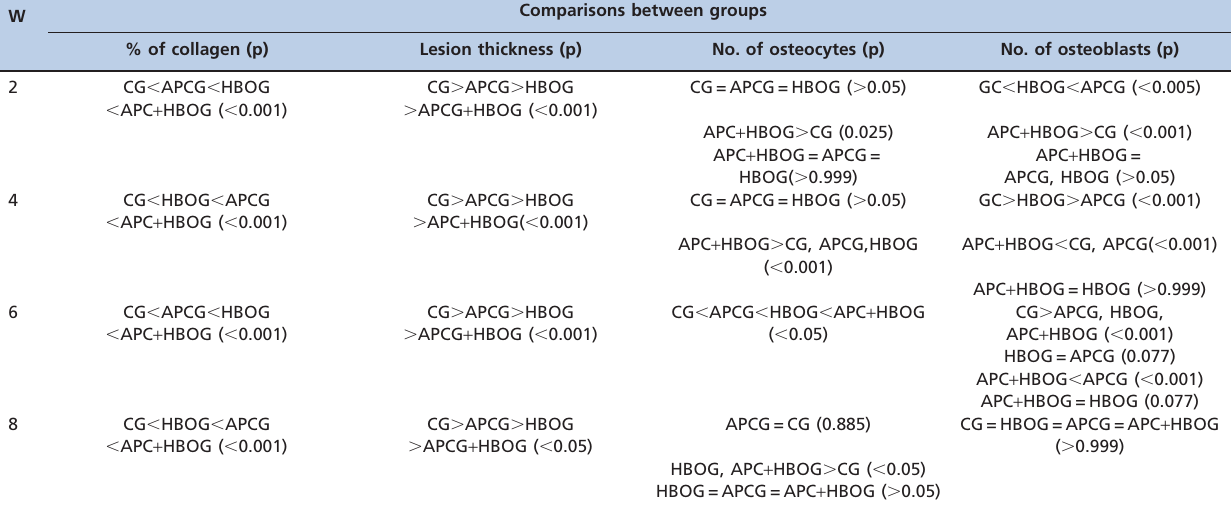
Table 2 - Multiple comparisons of the average percentage of collagen, average number of osteoblasts and osteocytes, and average lesion thickness, according to groups and euthanasia periods